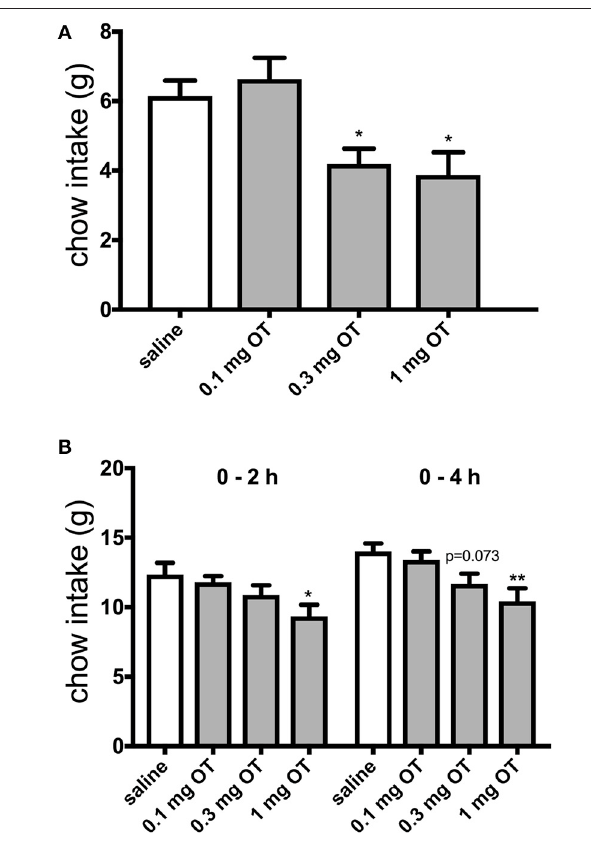
FIGURE 1 | Effect of i.p. OT injection (0–1.0 mg/kg) on HFHS chow intake after a period of having no access to food for 2h (A) or 22h (B) . Saline was the vehicle. HFHS availability period was 2h in the sated (2-h deprived) rats and 4h in the 22-h deprived animals. Water was available ad libitum. OT at 0.3mg and 1 mg/kg decreased HFHS food consumption [ F (3,32) = 6.44; 0.3mg, p = 0.042; 1mg, p = 0.016] during the 2-h access period (A) . In animals subjected to 22-h food deprivation after which they gained access to the HFHS chow, 1 mg/kg OT decreased consumption at 2h [ F (3,32) = 3.38; p = 0.015] and 4h [ F (3,32) = 5.12; p = 0.004] of re-feeding (B) . There was a trend toward a decrease for 0.3 mg/kg OT at 4h ( p = 0.073). * p < 0.05; ** p < 0.01.